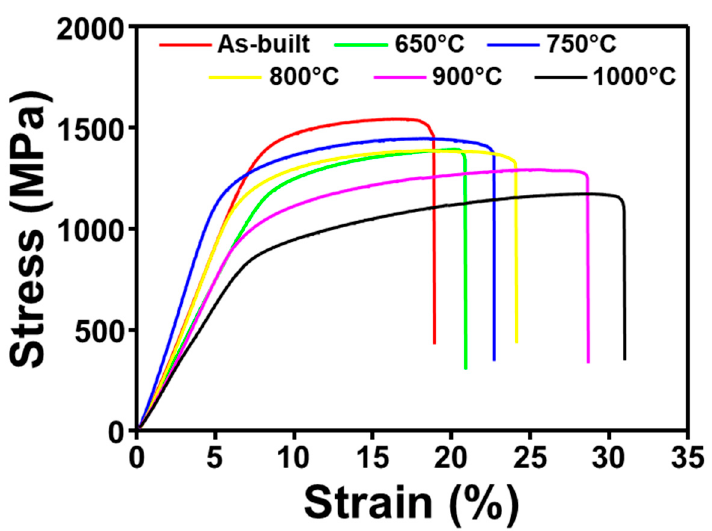
Figure 6. Compressive stress–strain diagrams of as-built and heat-treated SLM Ti-6Al-4V alloys.